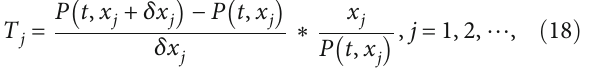
Figure 5: Model predictions of internal resistance variation in case of di ff erent initial salt